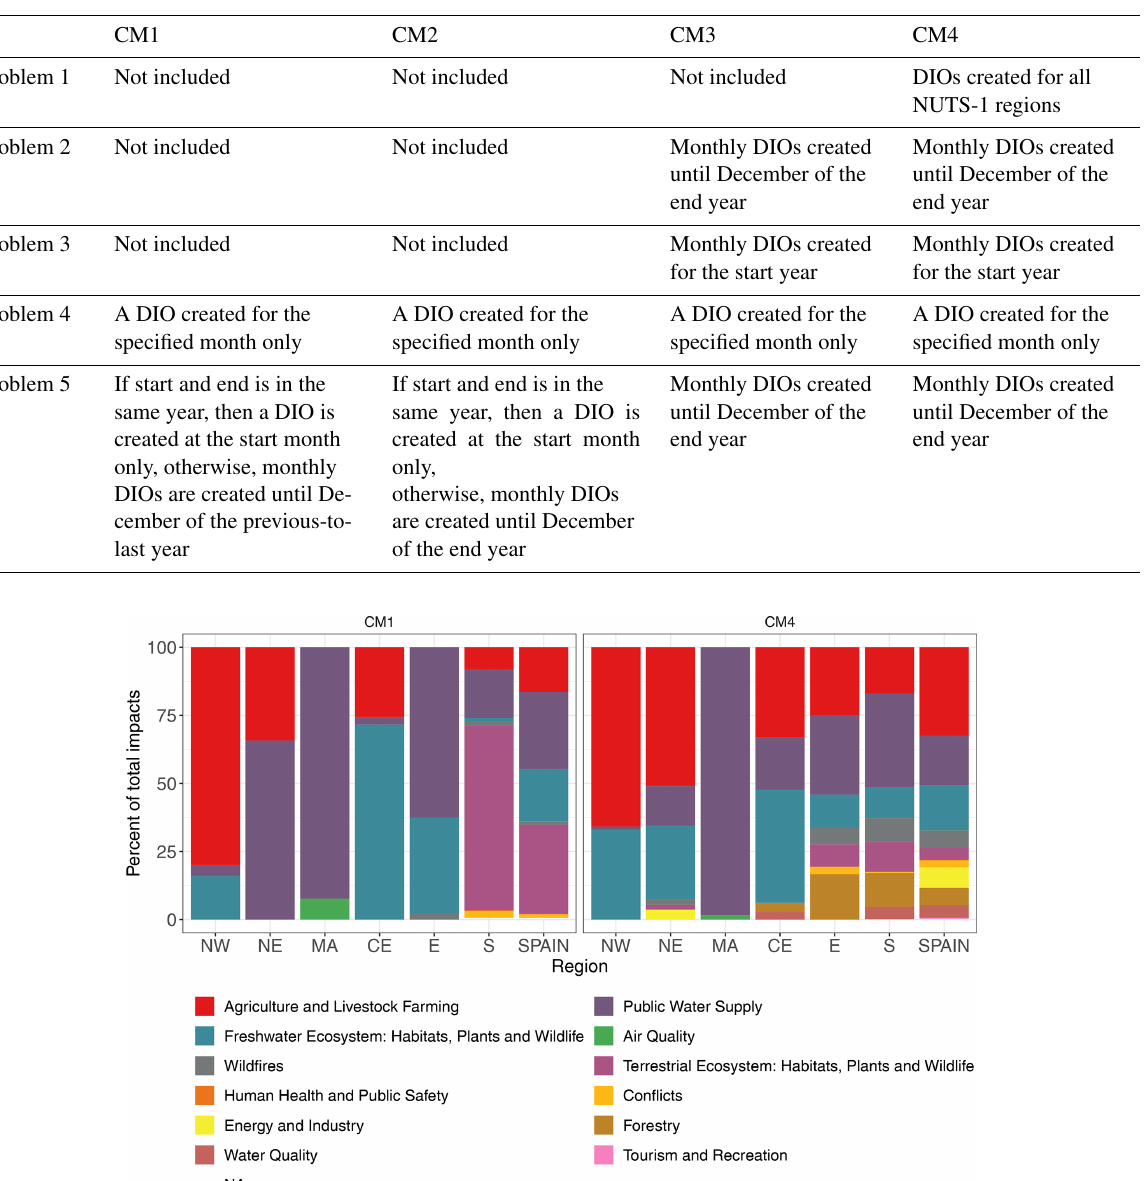
Table 1. How drought impact occurrences (DIOs) are counted in each counting method.